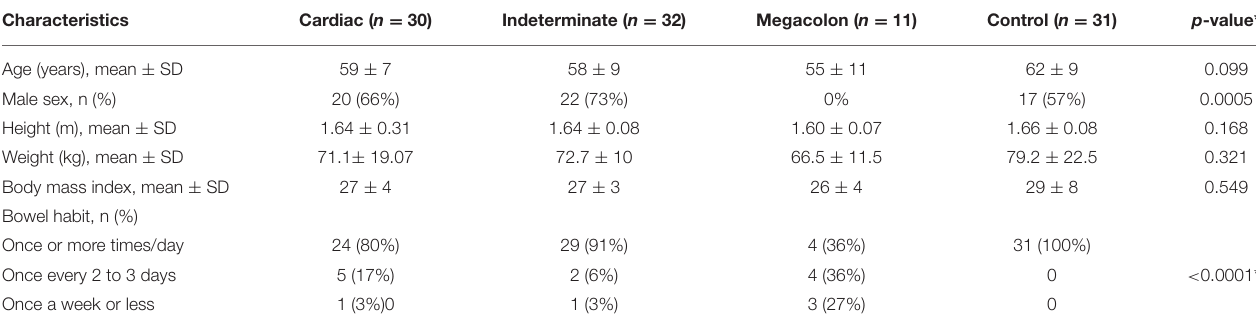
TABLE 1 | Epidemiological and clinical characteristics of 73 participants with three different Chagas disease phenotypes, cardiac, indeterminate, and megacolon, and 31 controls.